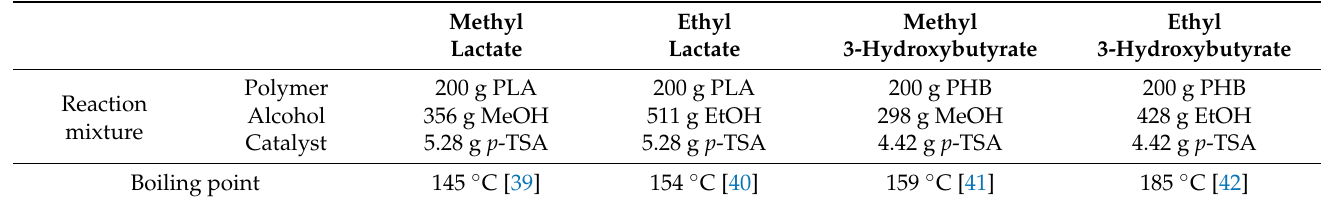
Table 1. Depolymerization mixture components and boiling point values of synthesized monoesters.